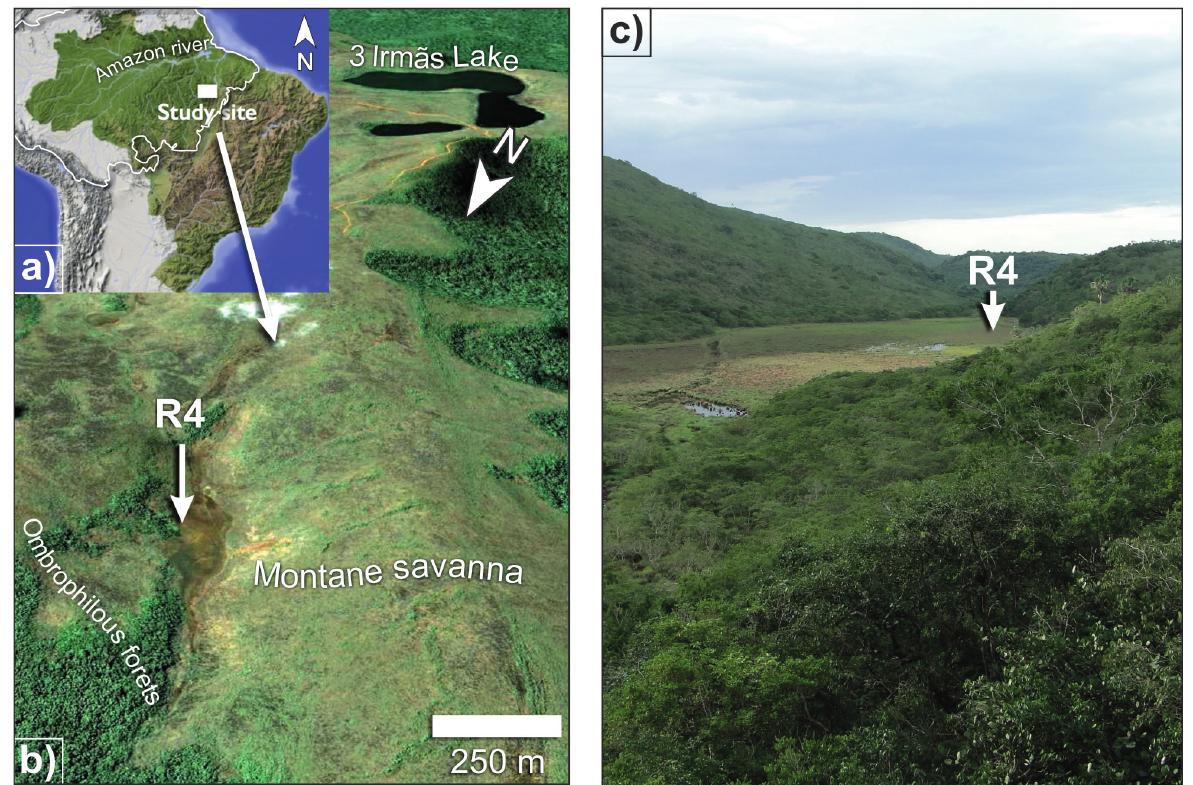
Figure 1 - a) Location of the study site and its position into South America and biogeographic limits of the Amazonia (rAISG 2009). b) Location of the studied Lake (r4 core) in the western portion of the Serra Sul dos Carajás (Source: Google Earth Pro). c) Oblique photography of the studied lake with location of the r4